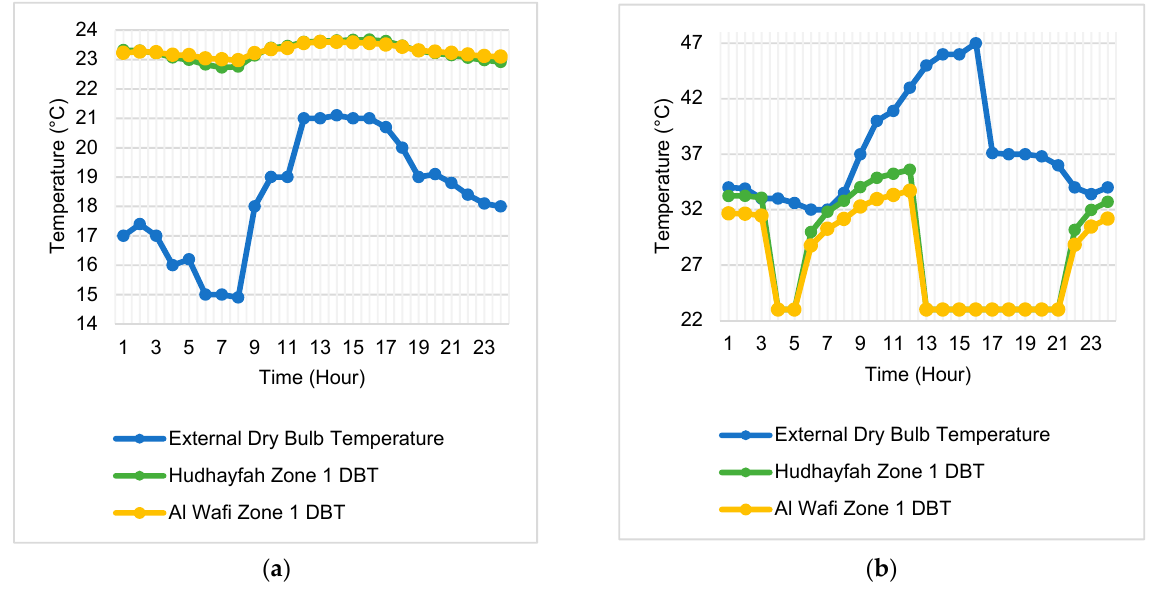
Figure 18. ( a ) Comparison between Hudhayfah and Al Wafi mosque’s Zone 1 dry bulb temperatures during Day 20 (Winter); ( b ) Comparison between Hudhayfah and Al Wafi mosque’s Zone 1 dry bulb temperatures during Day 179 (Summer).